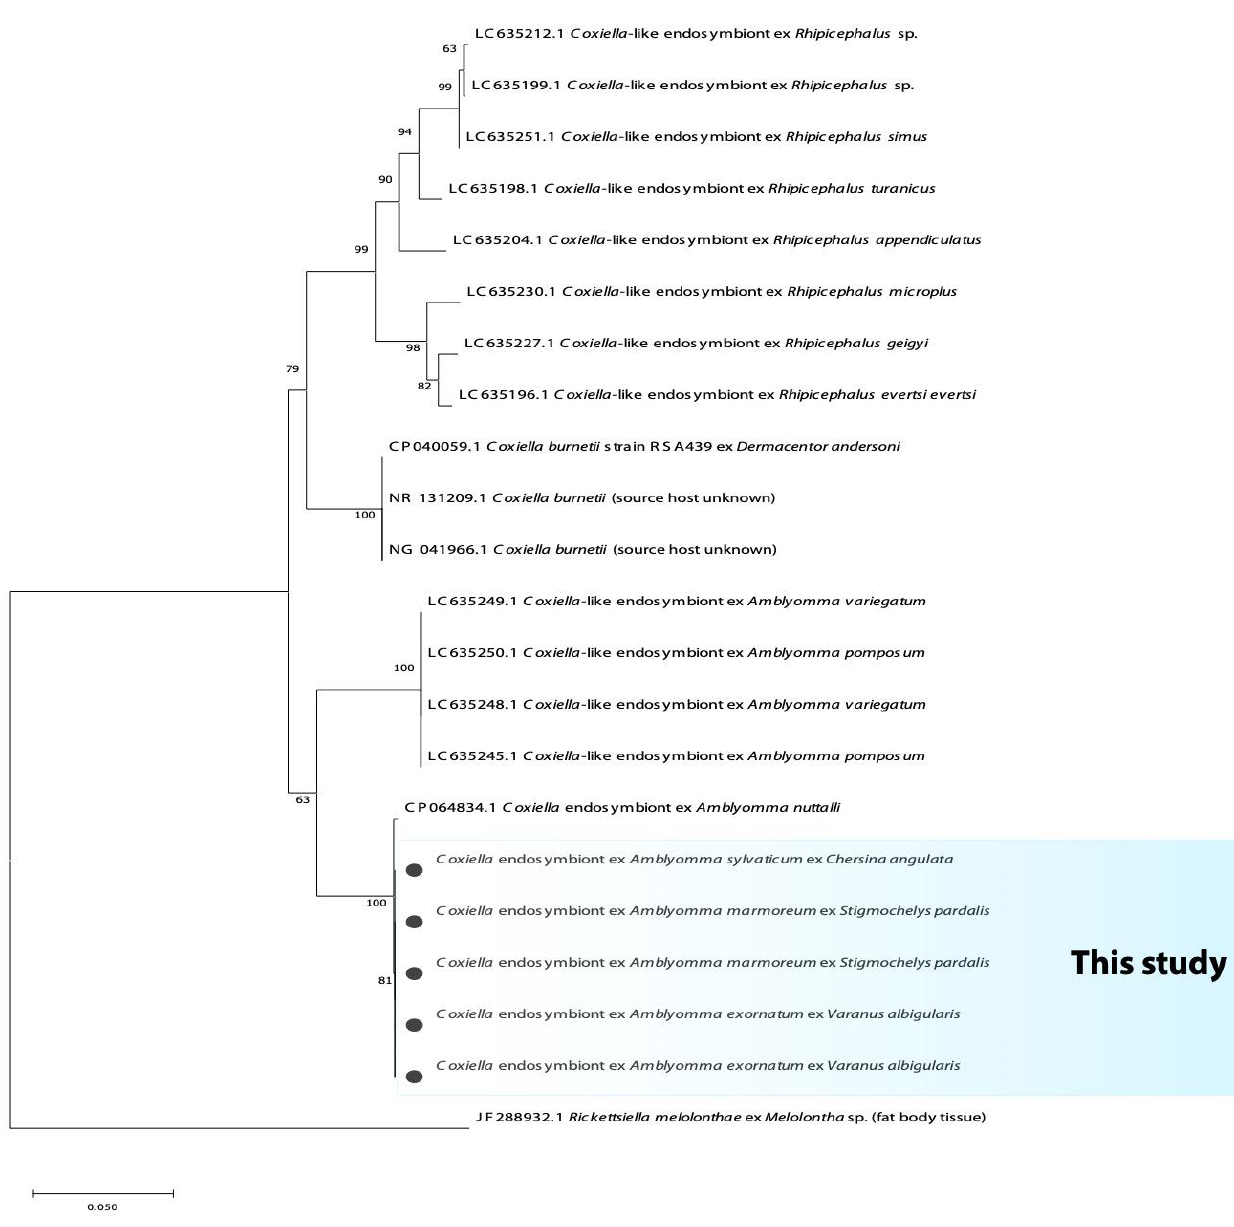
Figure 5. Phylogenetic tree based on the sequences of the Coxiella 23S rRNA gene. The tree was constructed using MEGA 11 based on the maximum likelihood, using the Kimura 2-parameter model. The sequences obtained in this study are indicated with bullets.